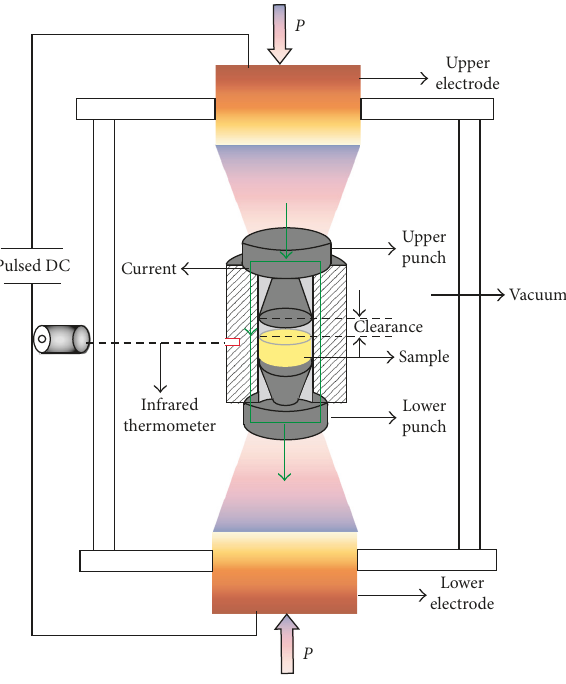
Figure 1: A schematic of SPS for synthesis without